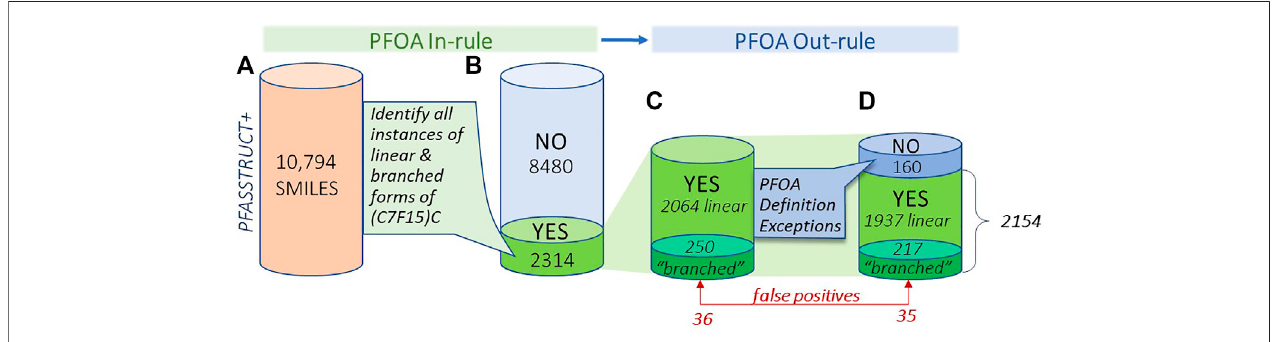
FIGURE6| VisualsummaryoftheresultsofapplicationofthePFOAIn-ruleandPFOAOut-ruletothePFASSTRUCT+SMILESset,showingnumbersofstructures fallingintoeachbin,movingfromlefttoright; (A) initialsetofPFASSTRUCT+ (B) resultsafterapplicationoftheIn-rule(YES,NO); (C) structuressatisfyingtheIn-rule(YES), showing totals in the linear and branched subsets (D) totals after application of the Out-rule exceptions, with adjusted totals of linear and branched YES results.